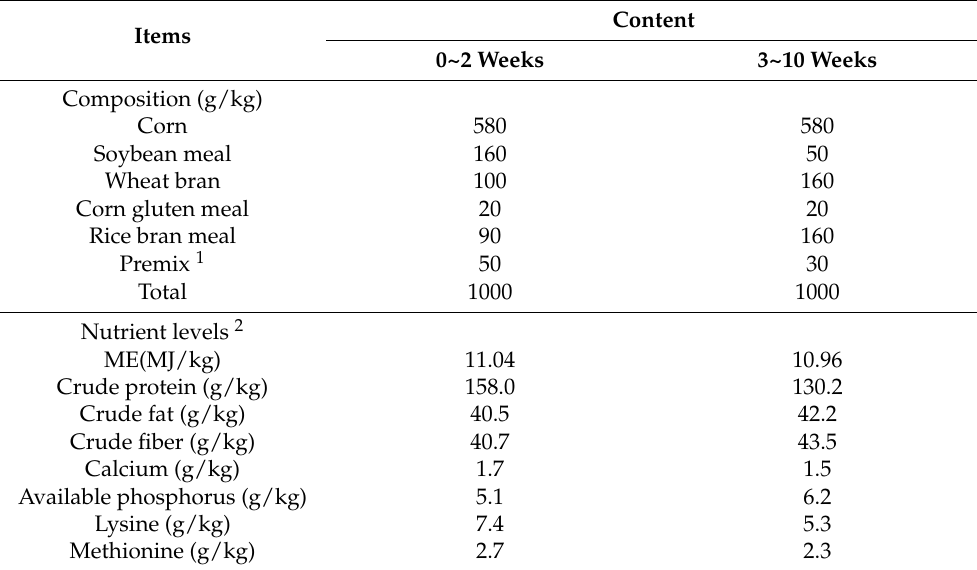
Table 1. Composition and nutrient levels of the experimental diets (air-dried